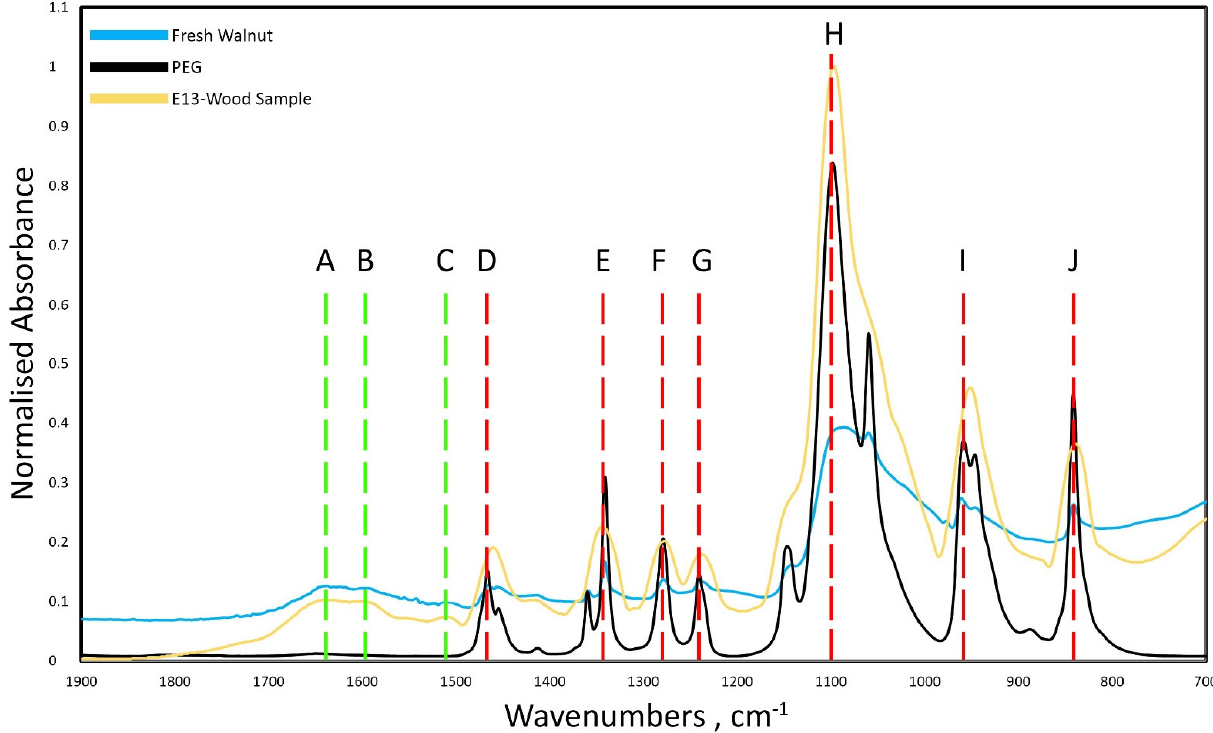
Figure 6. FTIR spectra collected for fresh oak, PEG, and the E9, E11, and E17 archaeological wood samples.